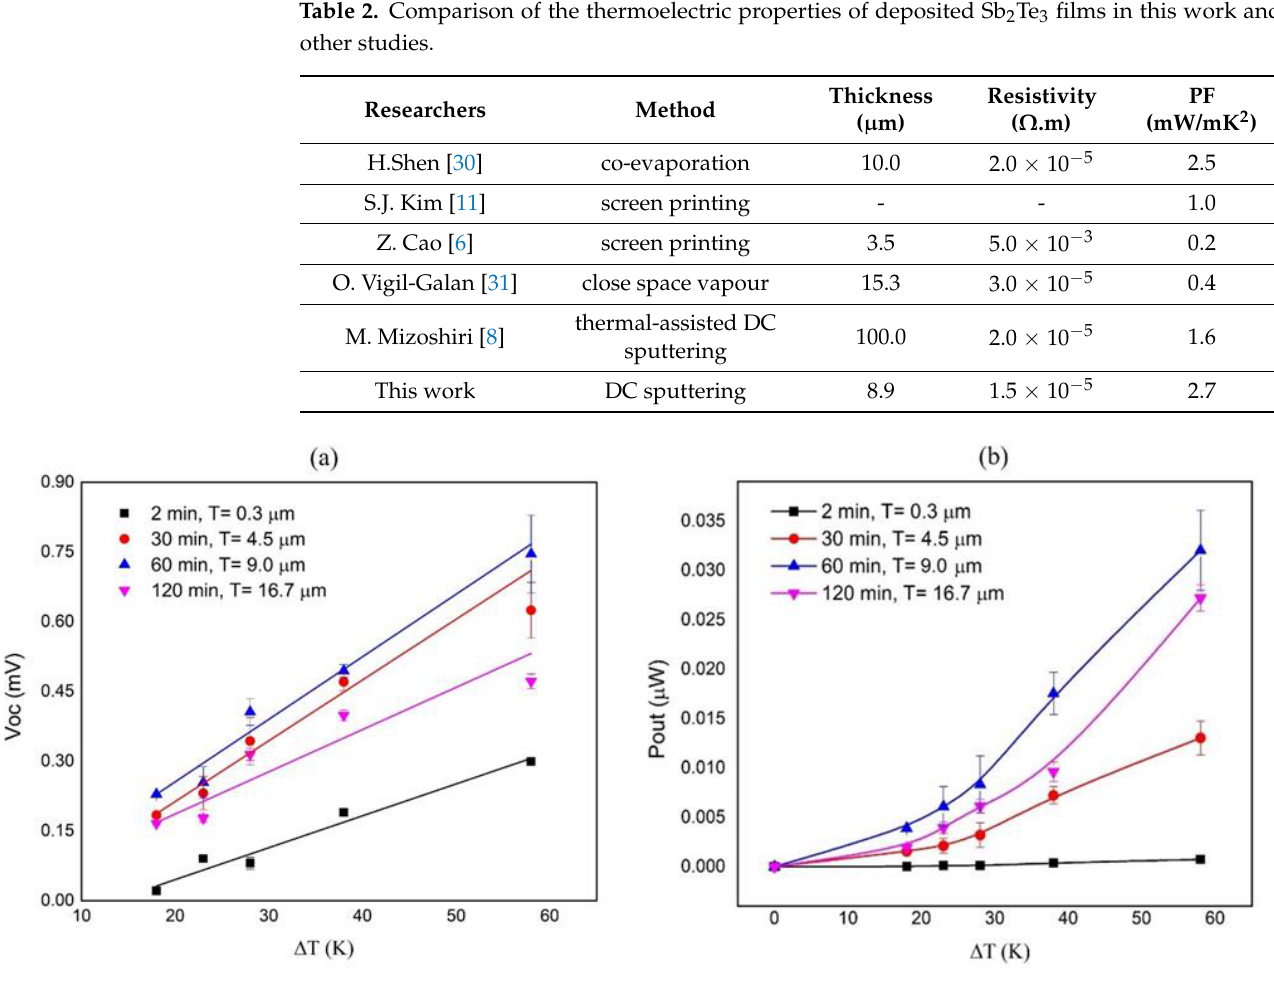
Figure 8. Temperature dependence of ( a ) Open circuit voltage and ( b ) Output power of single planar Sb 2 Te 3 films with different film thicknesses.